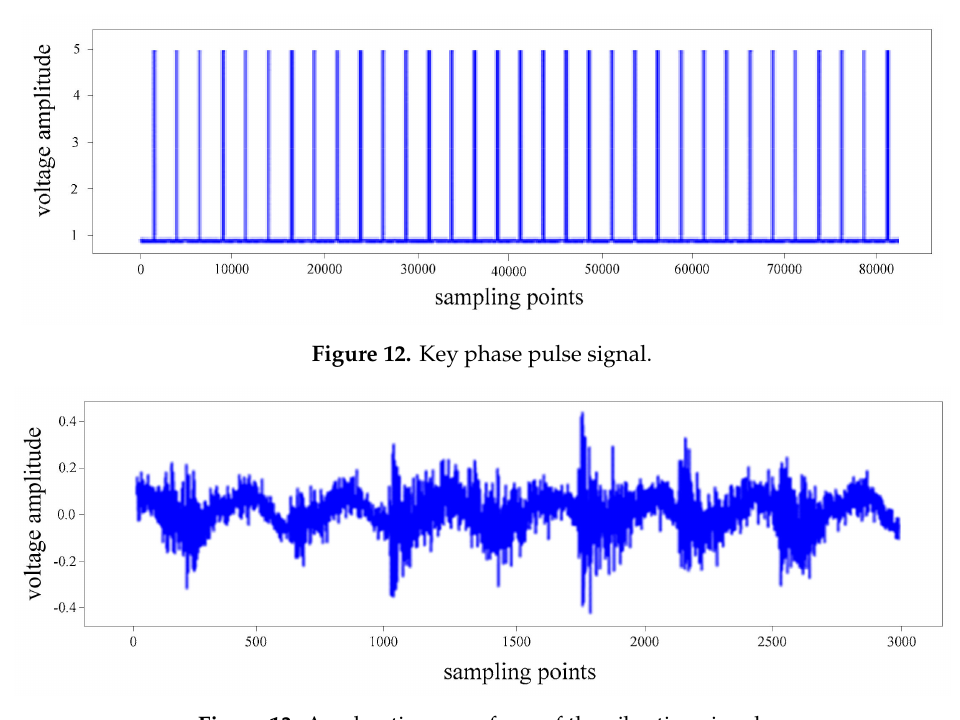
Figure 13. Acceleration waveform of the vibration signal.